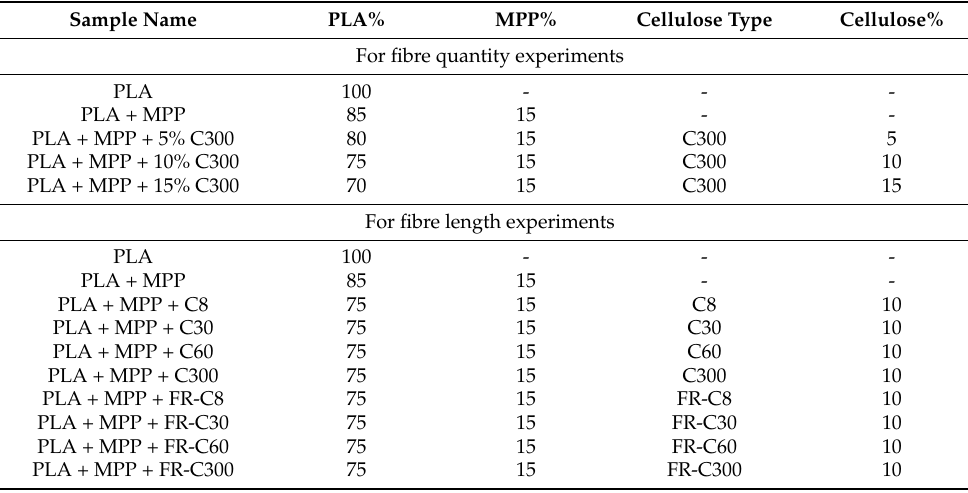
Table 2. Formulations of the PLA composites in the